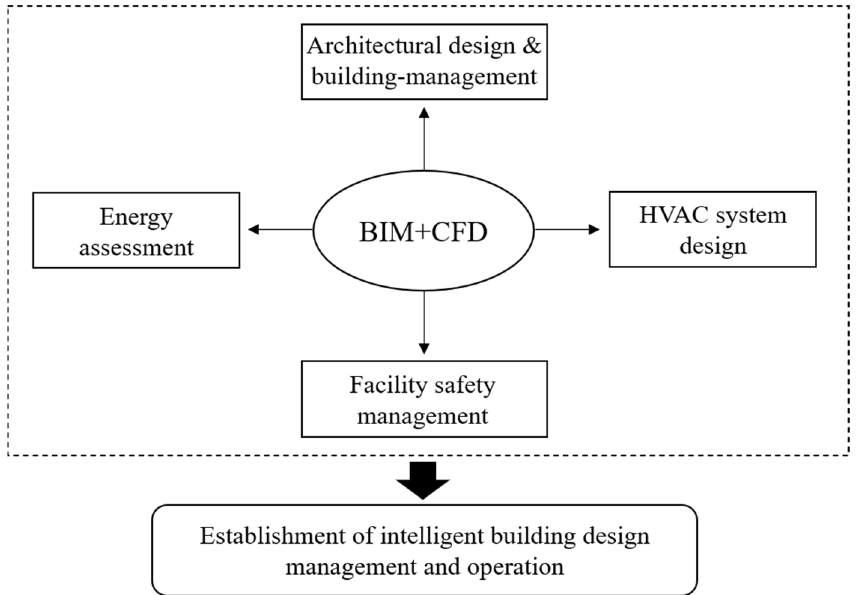
Figure 4. Key application of BIM–CFD integration.